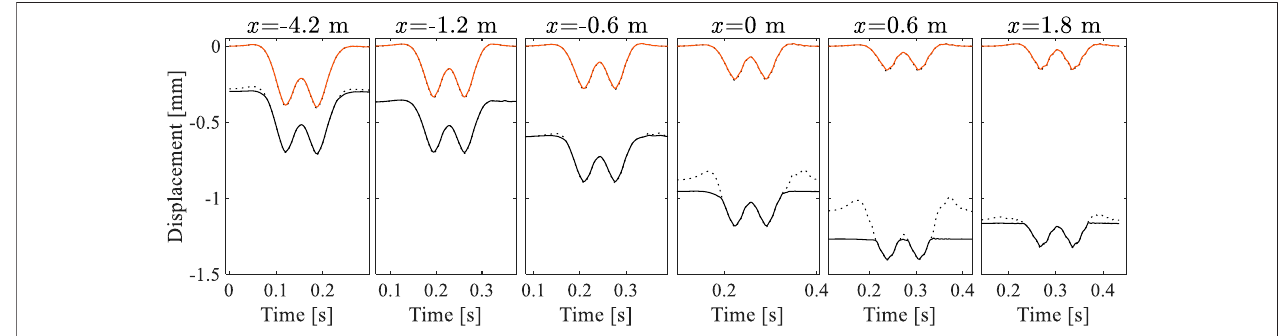
FIGURE 11 | Comparison between the de fl ections of the sleepers (doted lines) and of the ballast layer (full lines) as the vehicles passes by at load cycle N (cid:1) 1 (red) and N (cid:1) 100E3 (black).